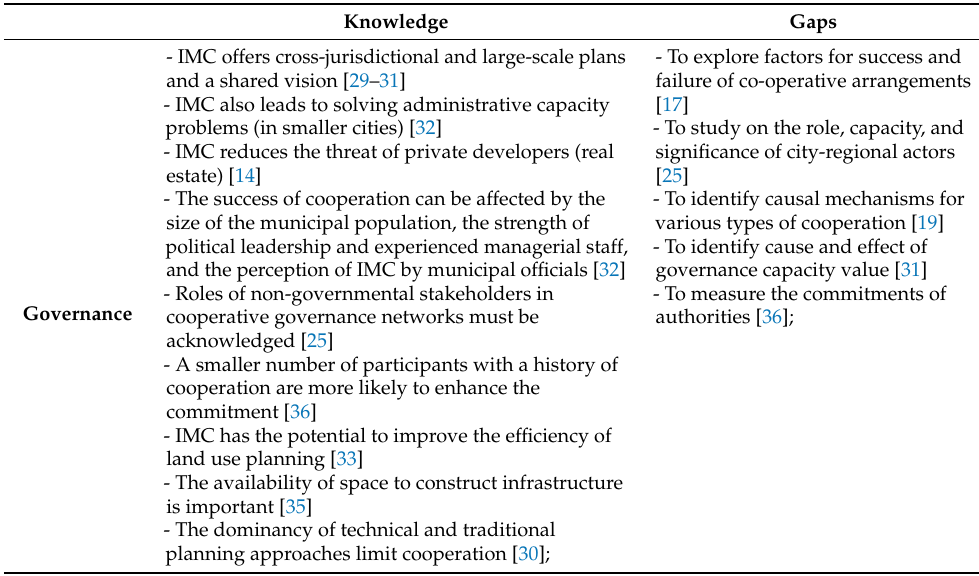
Table 3. Summary of emerging knowledge and gaps in IMC